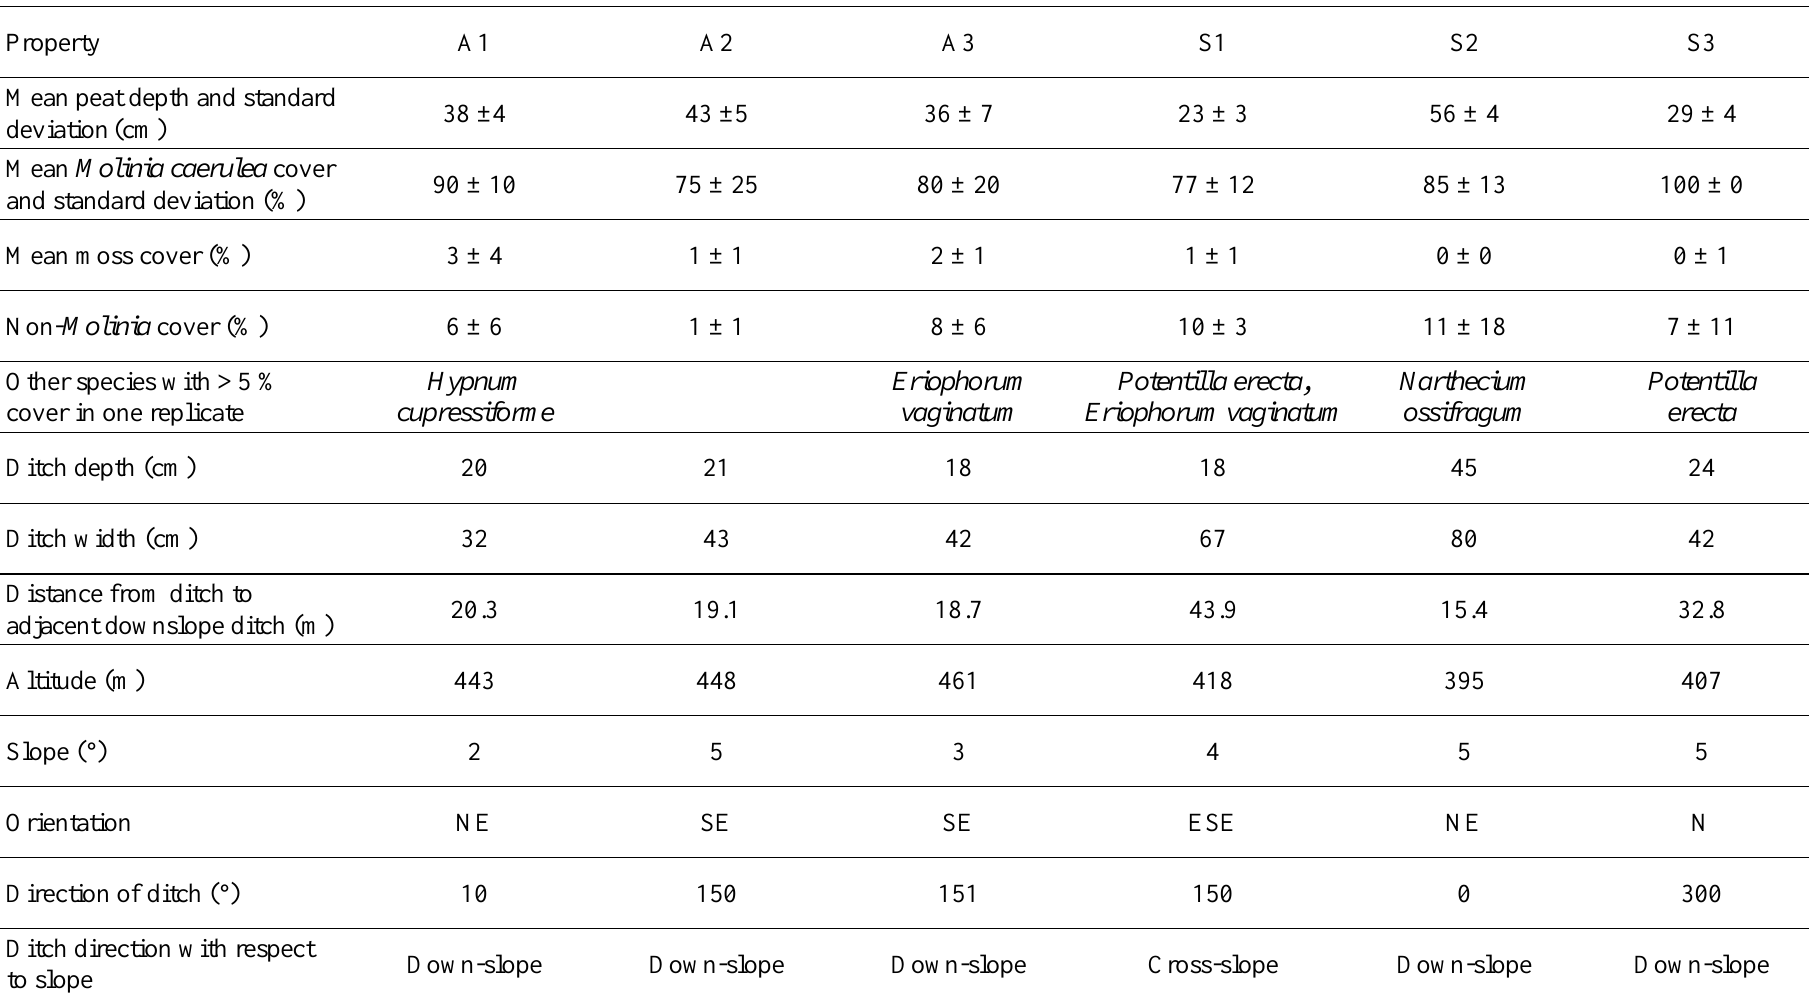
Table 1. Properties of the experimental sites at Aclands (A1–3) and Spooners (S1–3). Three replicates were located within each site. Peat depth (cm) measured from base of peat during dipwell installation. Ditch depth (cm) measured using a tape measure, from base of ditch to tussock shoulder. Ditch width (cm) and distance from ditch to adjacent down-gradient ditch (m) measured with a tape measure. Altitude (m), slope ( ° ), orientation and direction of ditch ( ° ) from LiDAR data.